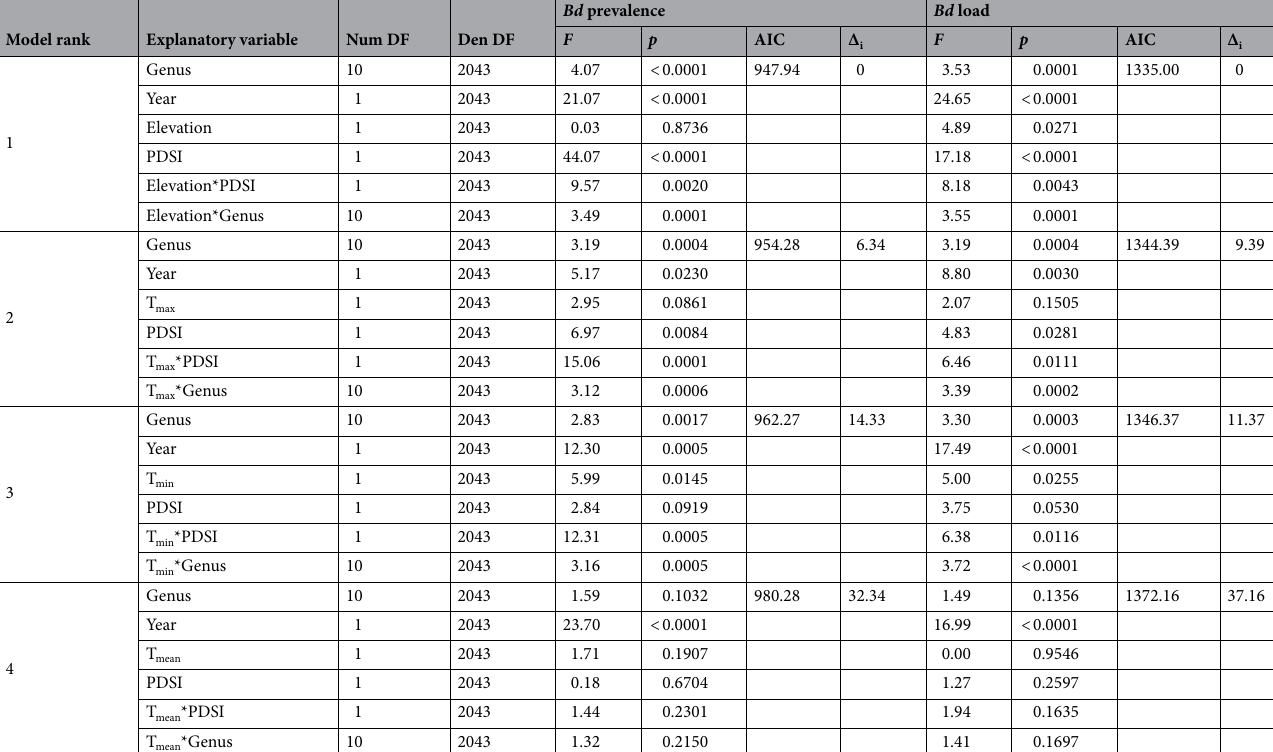
Table 1. Model results of the generalized linear mixed model analysis with Bd prevalence and Bd load as dependent variables and genus, year, elevation, Palmers Drought Severity Index (PDSI), yearly minimum (T min ), mean (T mean ), or maximum (T max ) temperature as explanatory variables. DF degrees of freedom, AIC Akaike’s Information Criterion, Δ i difference to best model.